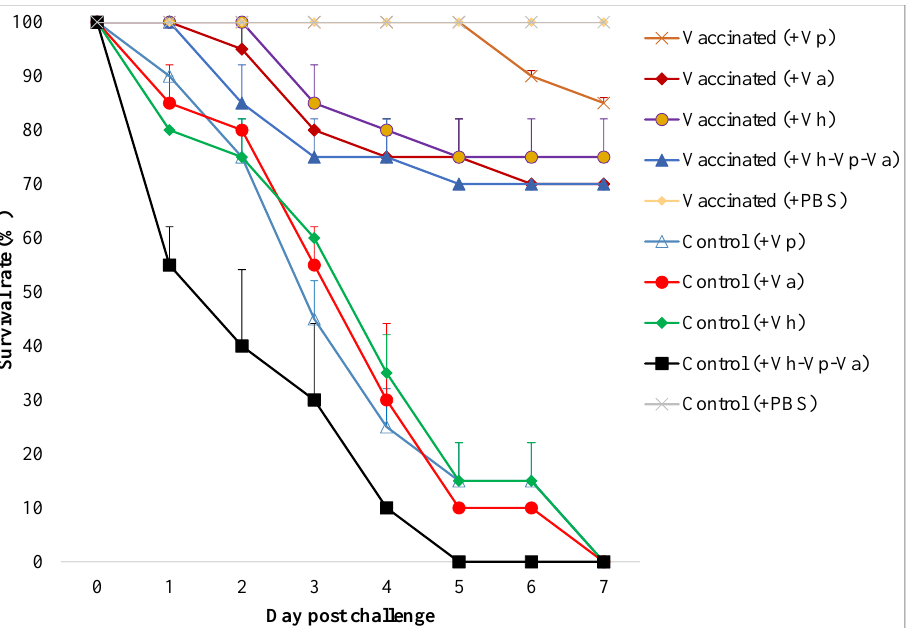
Figure 5. The survival rate of Asian seabass from vaccinated and unvaccinated control groups after challenging with PBS buffer (+PBS), single V. parahaemolyticus (+Vp), single V. alginolyticus (+Va), single V. harveyi (+Vh), or combined V. harveyi , V. parahaemolyticus , and V. alginolyticus (+Vh-Vp-Va). Each treatment was performed in duplicate with ten fish per challenge group ( n = 10). The upper half part of the standard deviation bars is shown. Table 4. Comparative efficacy of oral Vibrio harveyi strain VH1 vaccine candidate against different Vibrio spp. in Asian seabass ( Lates calcarifer ).